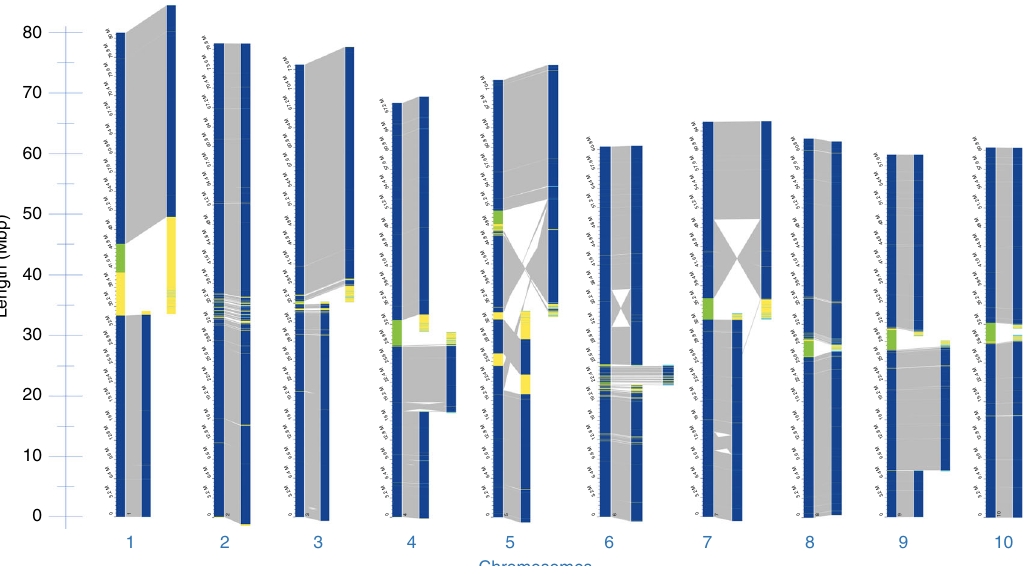
Fig. 5 Alignment of BTx623 maps against in-silico maps of the BTx623 reference assembly. Large inversions were detected on chromosomes 6 and 7 after aligning the BTx623 DLS map to in silico maps derived from the v3.0.1 public BTx623 assembly. A third inversion was detected on chromosome 5 while a separate inversion originally detected on chromosome 9 (Fig. 2) was absent in BTx623 . Chromosomes are listed in numerical order. Regions in green are stretches of random nucleotides in the reference assembly. Regions in yellow exhibit breaks in collinearity between the two maps